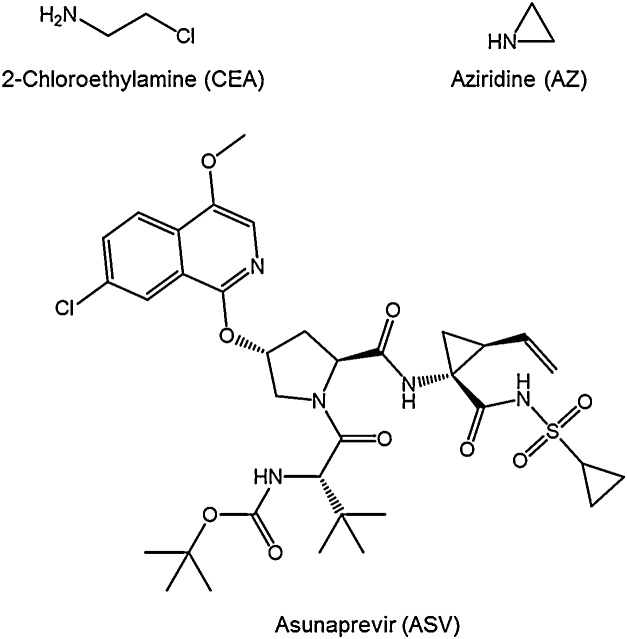
Analyte and drug compound structures.